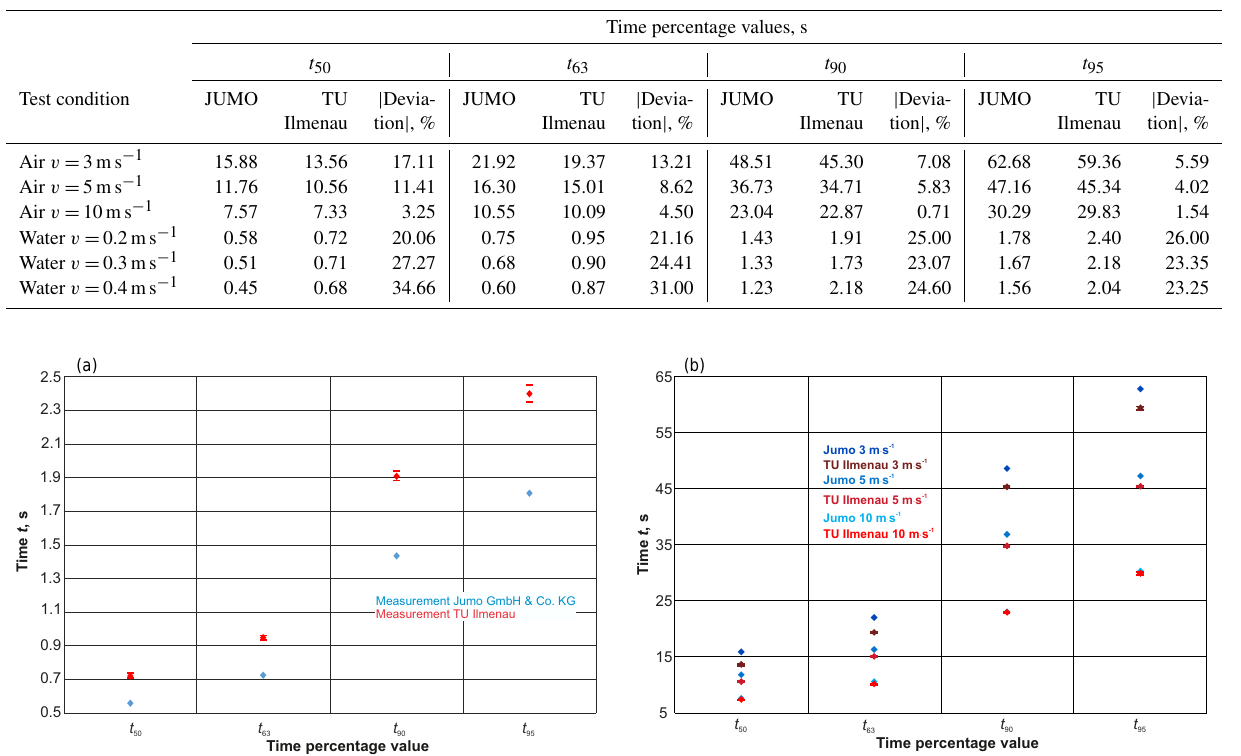
Table 3. Time percentage values determined for the thermocouple d = 3mm and (cid:49)T = 25K.